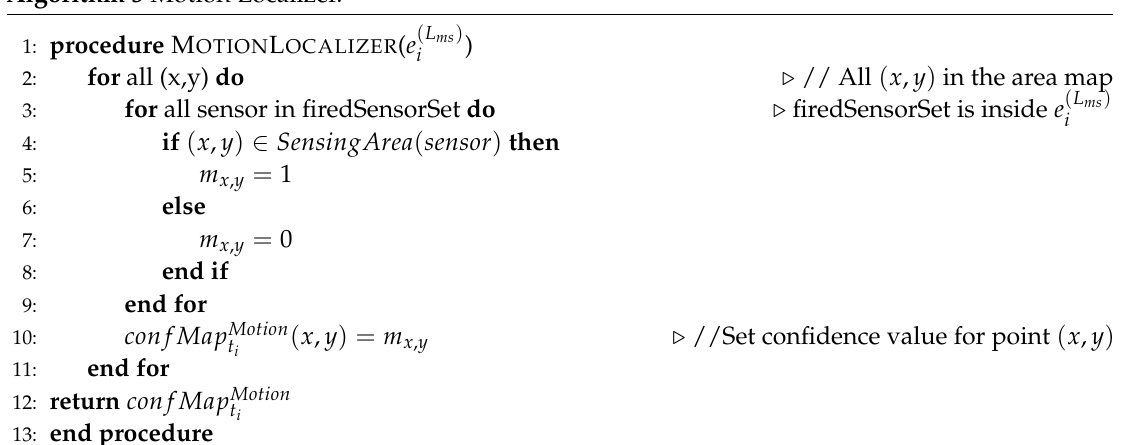
Algorithm 3 Motion